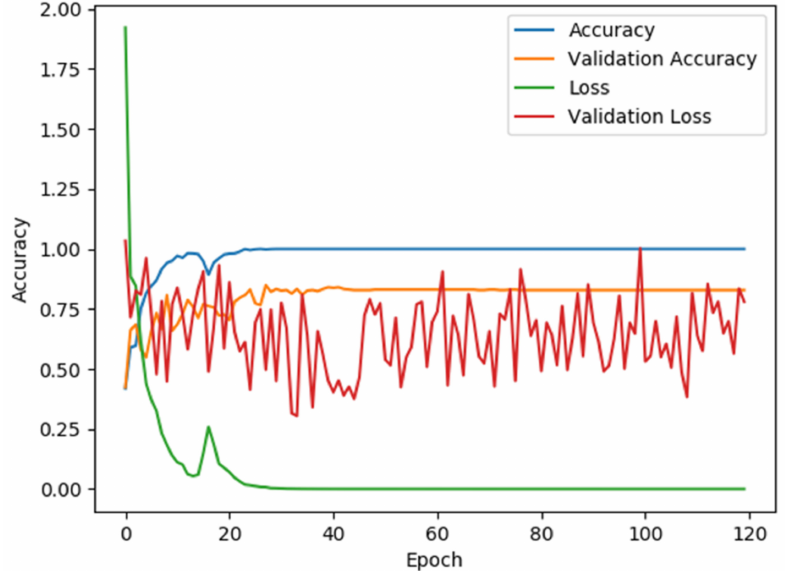
Figure 7. Variation of the accuracy and well as the loss during the training of the vision-based prediction model. Notice how the validation loss, in comparison to the other plots, was inconsistent with heavy fluctuation.